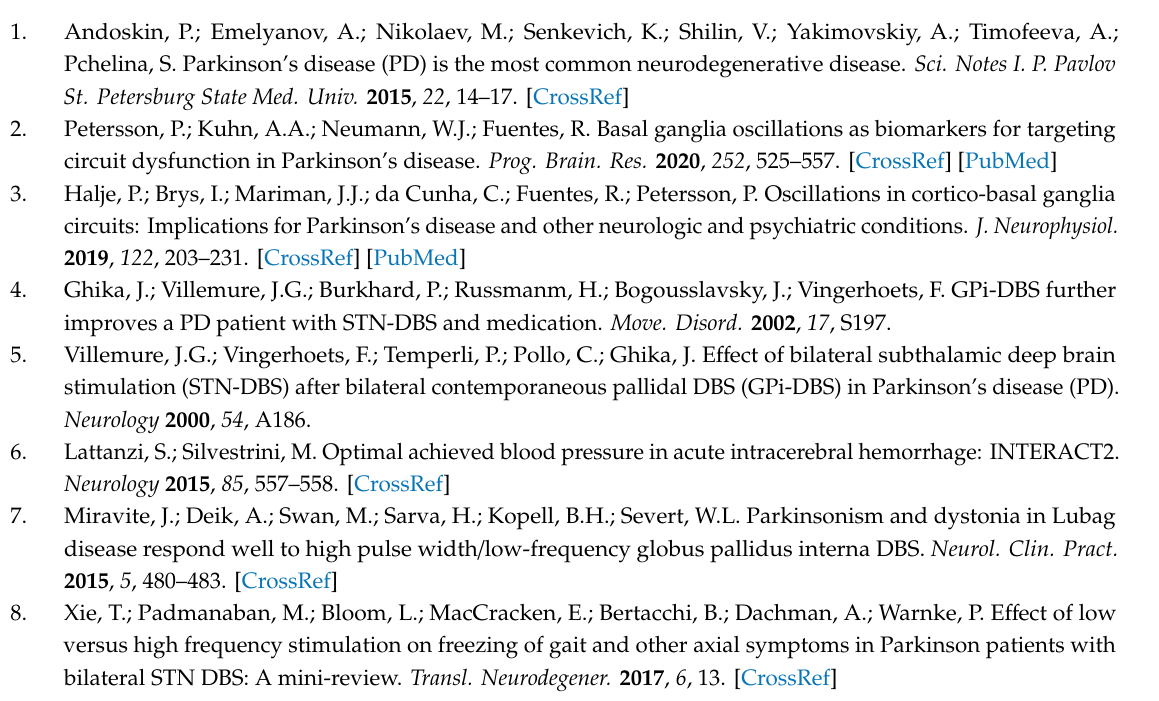
Figure S1: The fabrication process of the MEA, Figure S2: The detection system including DA recording and electrical recording under stimulation, Figure S3: Background noise comparison before and after modification of Pt / rGO, Figure S4: Impedance comparison before and after modification of Pt /